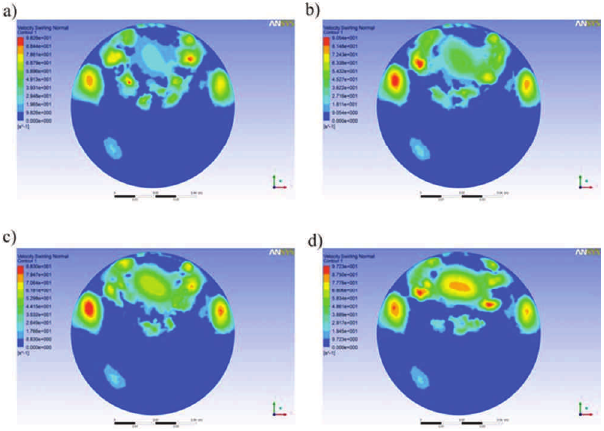
Fig. 13. The distribution of swirl inside the cylinder for charge’s flow velocity w = 12 m/s; a) q = 6 deg, b) q = 12 deg, c) q = 18 deg, d) q = 24 deg The surface area of the swirl air flow increases because of the tape-twisting angle, and it is also proportional to the increase of the initial air flow velocity. This relation was evaluated using the coefficient swirl area (SA), which is expressed in equation (7):